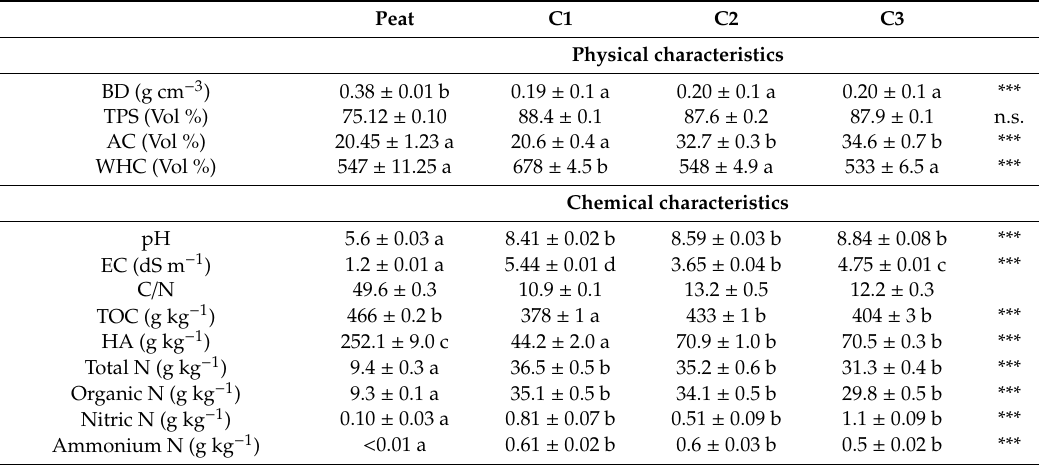
Table 2. Main physical, chemical, and biological characteristics of the composts